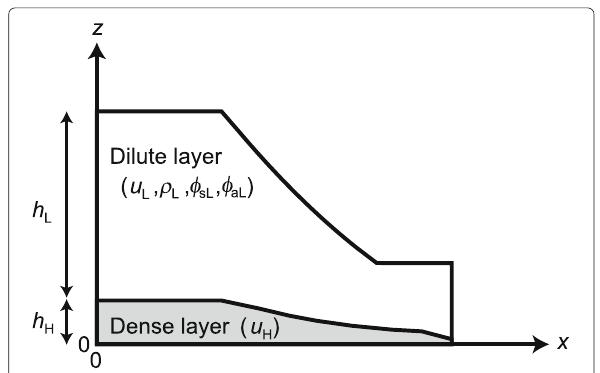
Fig. 13 Two-layer PDC model schematic. In the overlying dilute layer, the thickness h L , velocity u L , bulk density ρ L , particle volume concentration φ sL , and air volume concentration φ aL evolve both temporally and spatially. In the underlying dense layer, the thickness h H and velocity u H evolve both temporally and